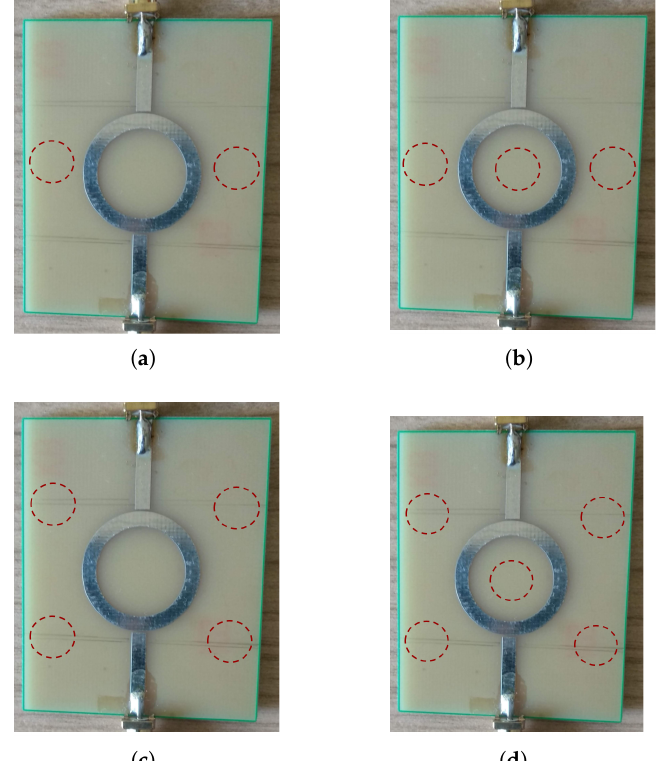
Figure 8. The four finger-press configurations with respective finger spots for the surface of an SUT. ( a ) 2-finger configuration. ( b ) 3-finger configuration. ( c ) 4-finger configuration. ( d ) 5-finger configuration.